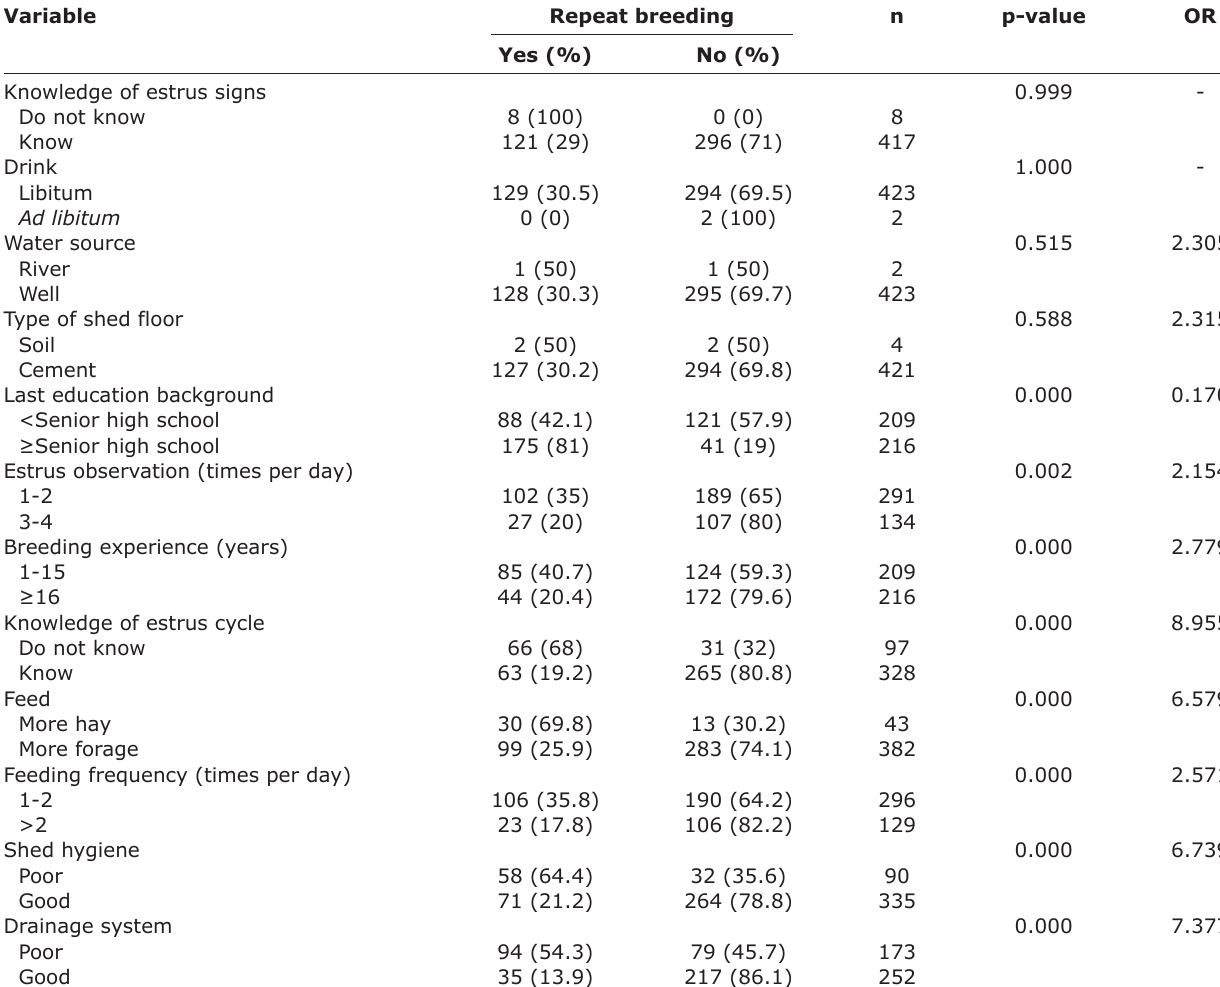
Table-4: Bivariate analysis of risk factors for repeat breeding in beef cattle in Sleman Regency, Indonesia. Variable